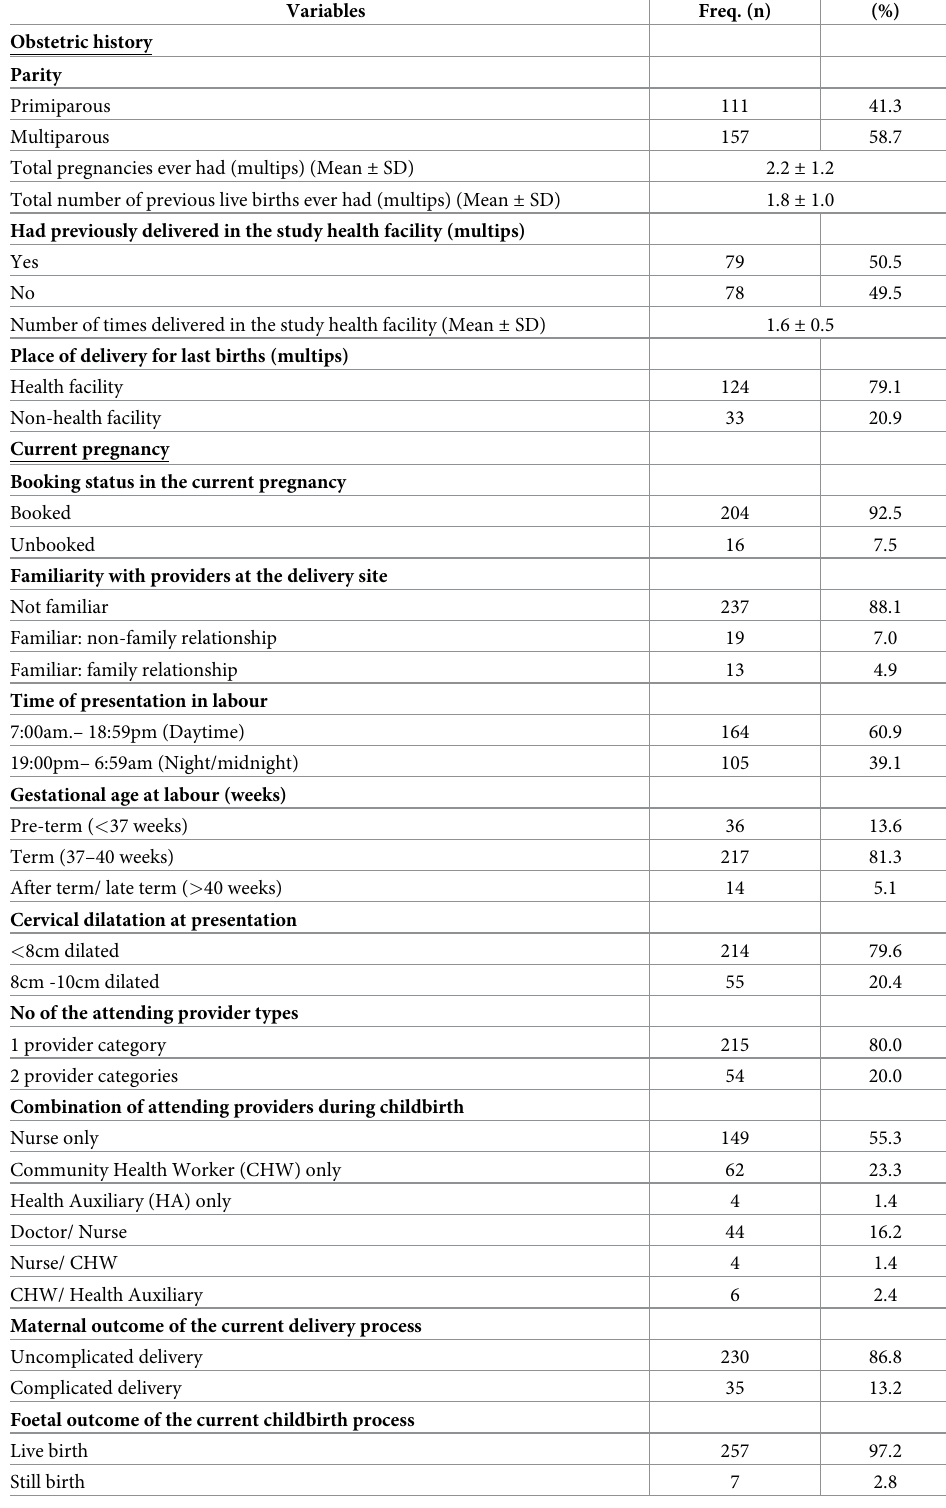
Table 3. Women’s characteristics in labour and obstetric history reported at postpartum (n =